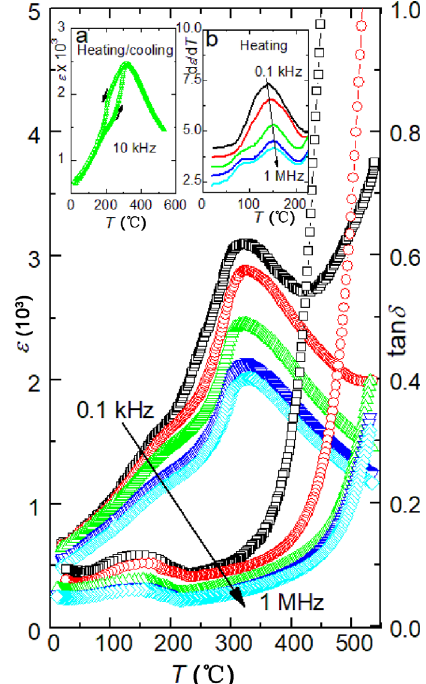
Fig. 2 Temperature/frequency evolution of electric permittivity ( ε ) and dielectric loss (tan δ ) of NBT ceramics. Inset (a) shows the temperature dependence of ε upon heating/cooling ( f = 10 kHz). Inset (b) shows the first derivative of ε in a narrow temperature